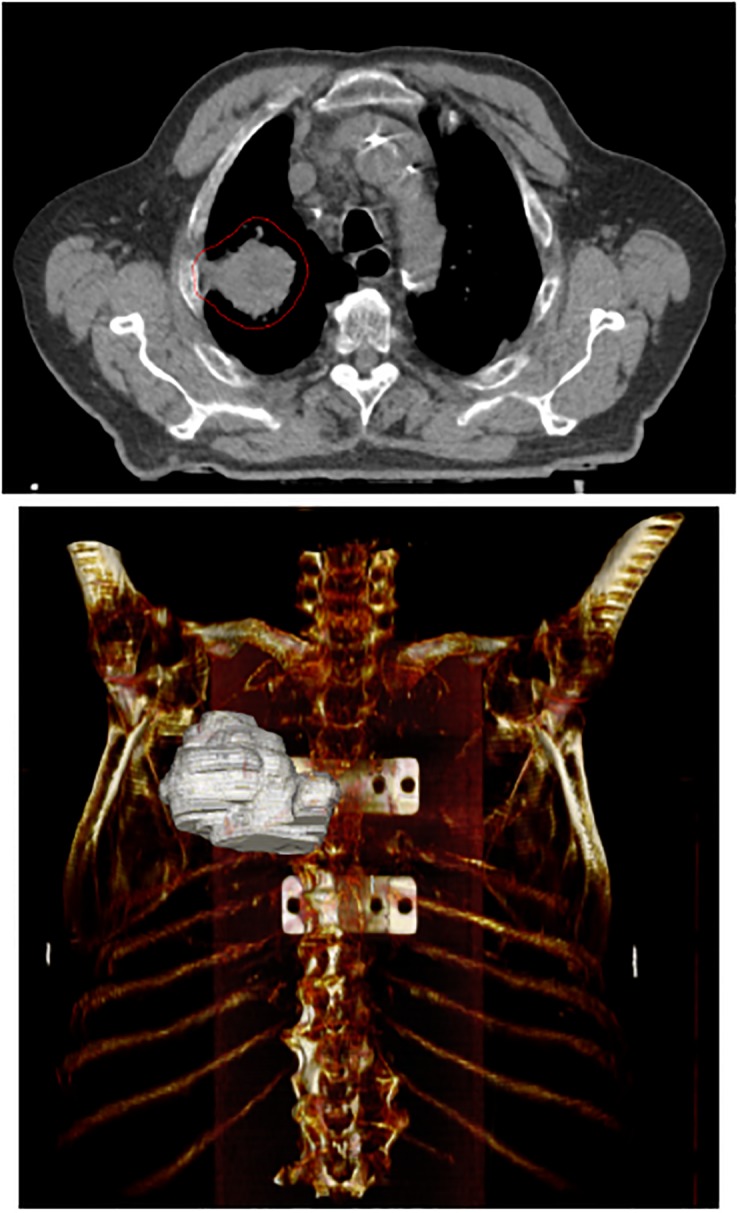
Example of ROI (Region of Interest) in 2D and 3D images for a patient in the non-adaptive group (mediastinal window).